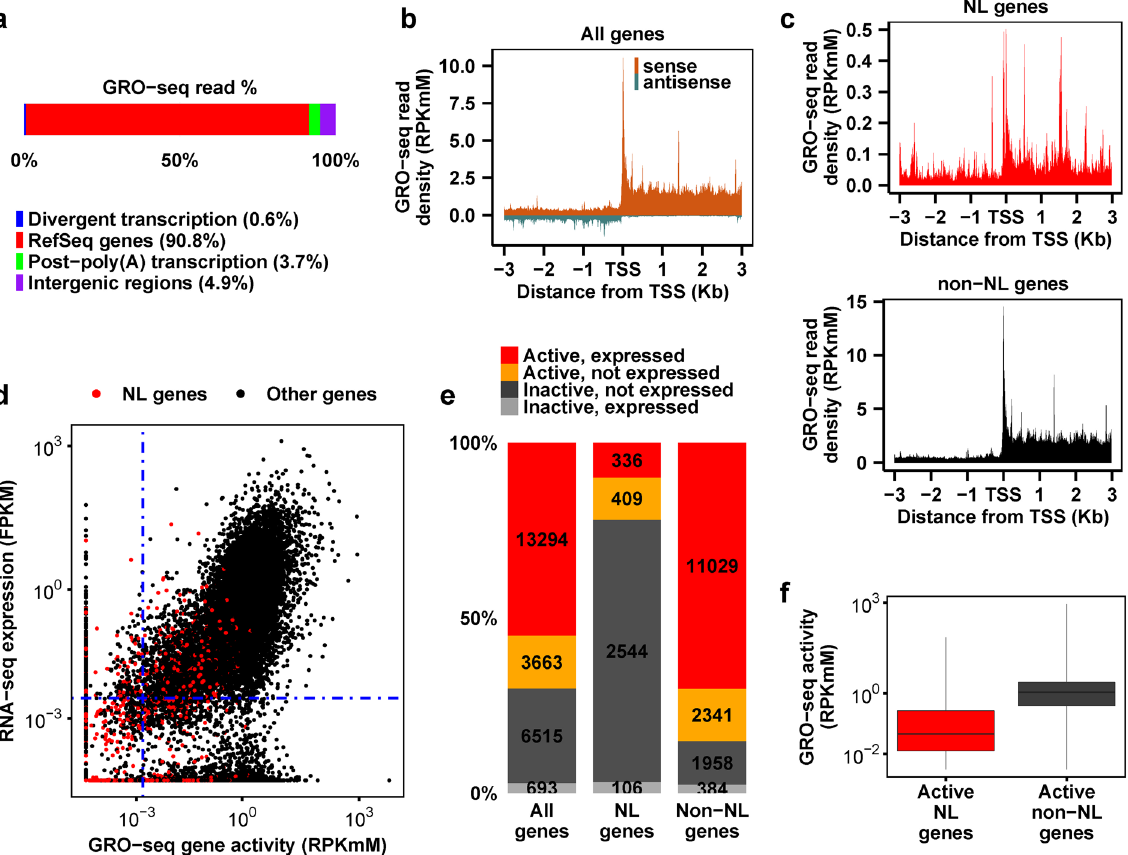
Figure 1. Genome-wide transcriptional activities measured by GRO-seq in C2C12 myoblasts. ( a ) The genome- wide distribution of GRO-seq reads. In total, 122 million GRO-seq reads were obtained from two biological replicates (Spearman’s ρ = 0.75 based on reads counts in 1 kb non-overlapping contiguous windows along the genome) and pooled for analyses. Reads in the 10 kb region downstream from the annotated TES on the same strand correspond to post-poly(A) transcription (green). Reads in the 5 kb region upstream from the annotated TSS on the opposite strand correspond to divergent transcription (blue). ( b , c ) Average GRO-seq read density in 10 bp bins along both sense and antisense strands among all genes ( b ) or along sense strands among NL genes and non-NL genes, respectively ( c ). ( d ) Scatter plot of RNA-seq gene expression against GRO-seq gene activity. NL genes are shown as red dots while all other genes are shown as black dots. Spearman’s correlation coefficients between the two variables are 0.79 for all genes, 0.67 for non-NL genes and 0.56 for NL genes (p-values < 2.2e- 16). Blue dashed lines indicate cut-off values for defining active genes and expressed genes, respectively. ( e ) Numbers and percentages of genes grouped by GRO-seq gene activity and RNA-seq expression. ( f ) Box plot comparing gene activities between active NL genes and active non-NL genes.